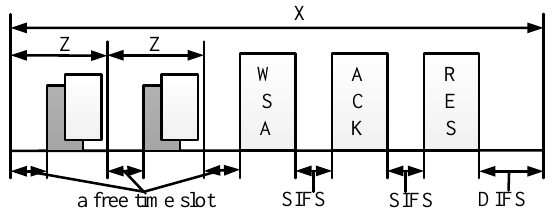
Figure 5. Contention model of making a reservation on the